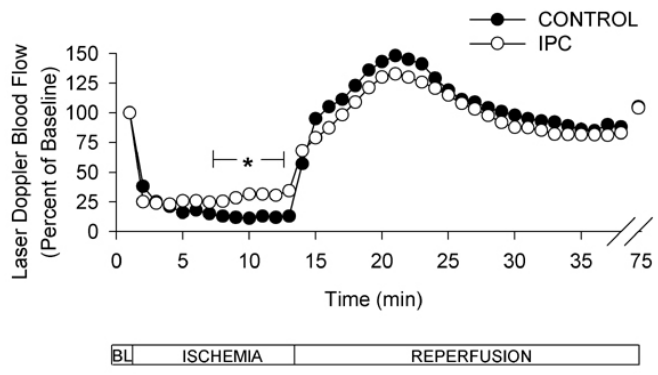
FIGURE 1 . Percent change in laser Doppler blood flow for baseline at the lumbar spinal cord. * = significant difference between groups in laser Doppler blood flow, p <